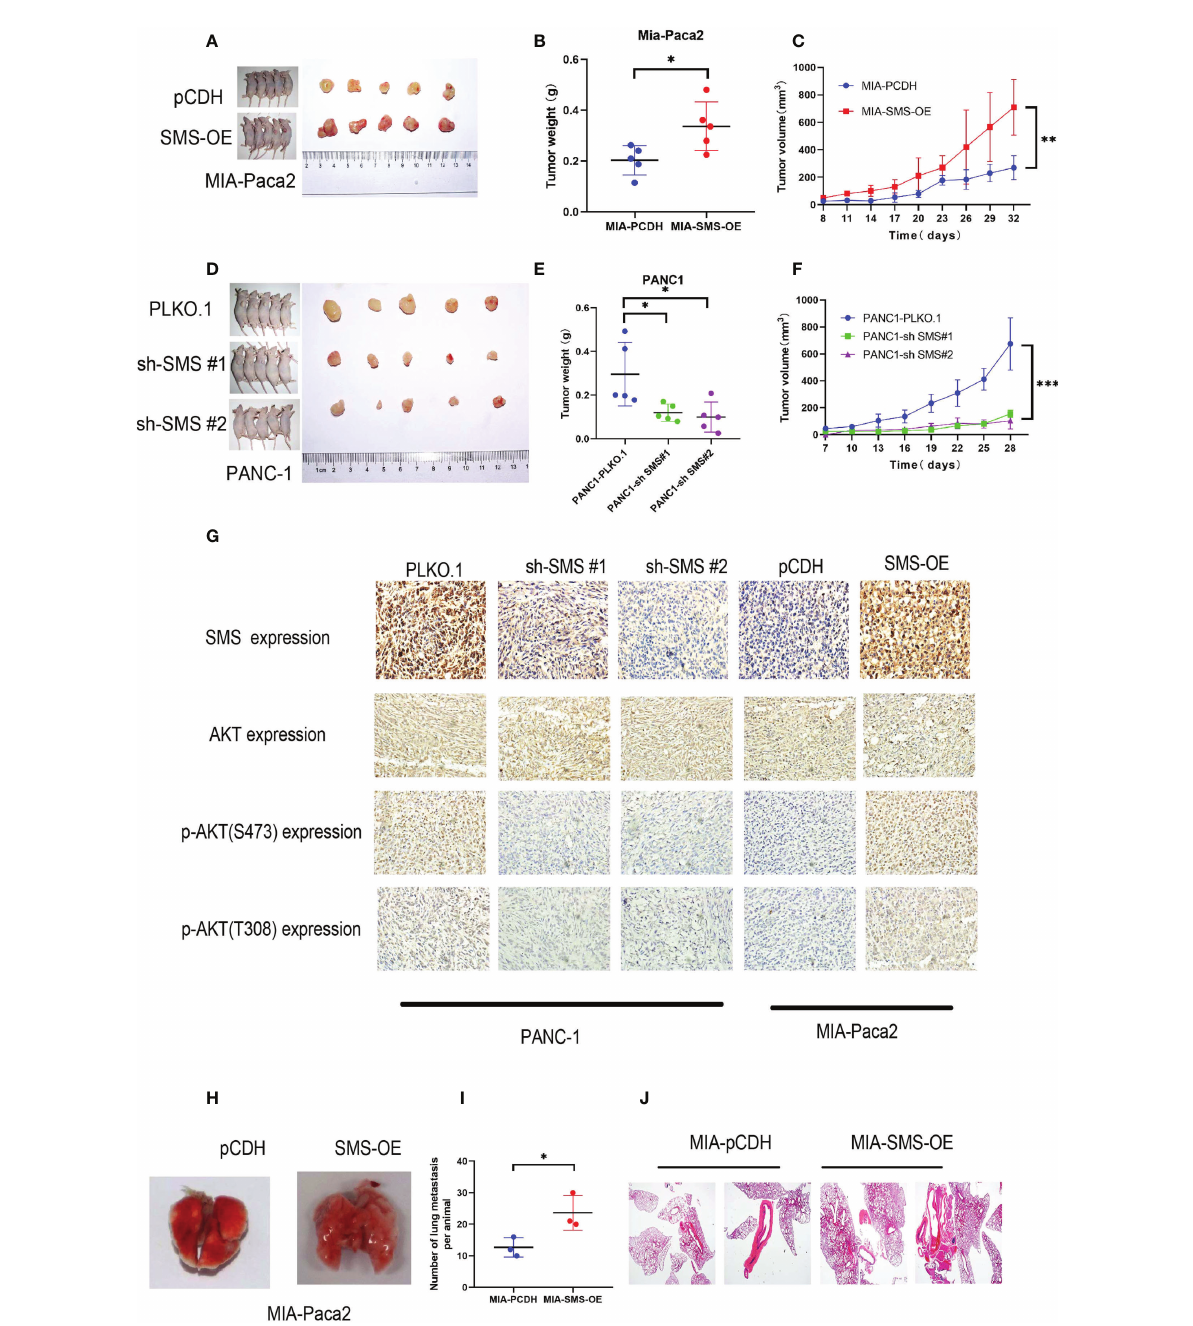
FIGURE 7 SMS can promote tumor growth and metastasis in vivo . (A, D) Tumor xenograft models were constructed with stable SMS-overexpressing (n = 5) or SMS-knockdown (n = 5) Mia-Paca2 cells and PANC1 corresponding negative control cells. (B, E) Then tumors were collected from sacri fi ced mice and tumor weights were measured. (C, F) The size of the tumors was measured at the indicated time points. (G) Tumors from mice were analyzed by IHC staining, Scale bar, 200 µm. (H-J) Representative images of lung metastasis and hematoxylin and eosin staining are shown. Metastatic nodules were counted with or without a microscope and recorded. Spd, spermidine;Spm, spermine.*P < 0.05; **P < 0.01; ***P <